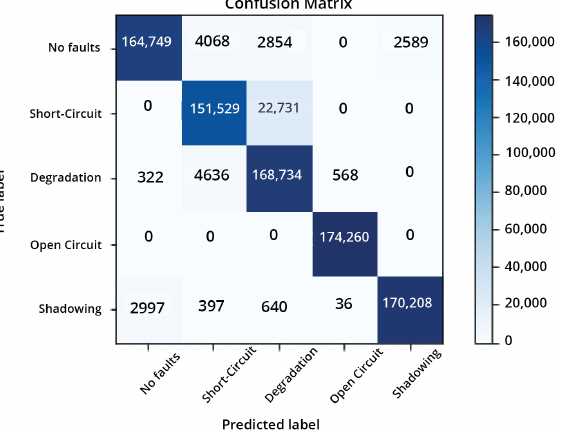
Figure 8. Confusion